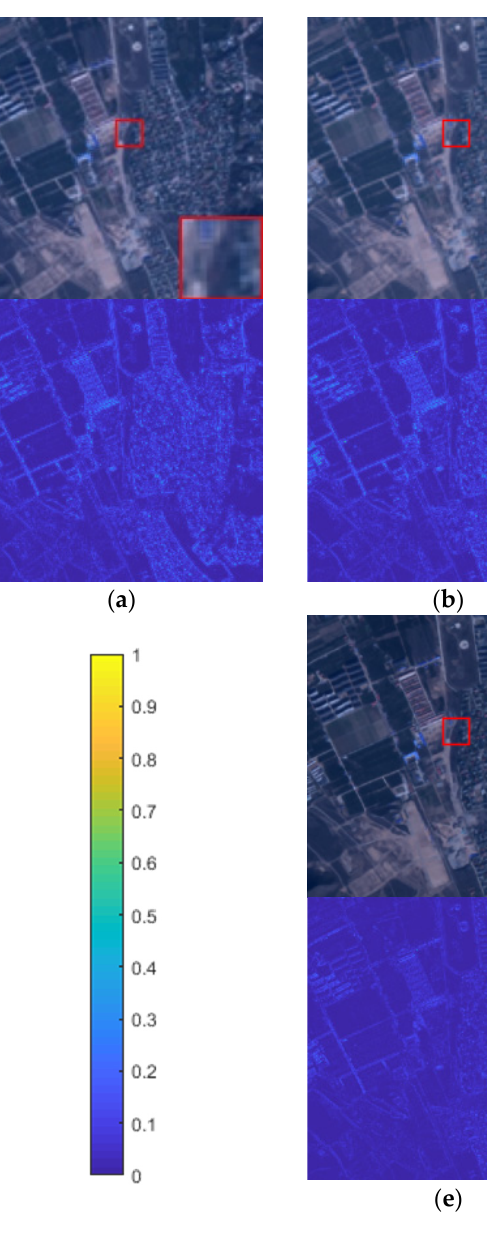
Figure 7. The ablation experiment result using the GaoFen-2 dataset. ( a ) ablation 1, ( b ) ablation 2, ( c ) ablation 3, ( d ) ablation 4, ( e ) LNFIN, ( f )